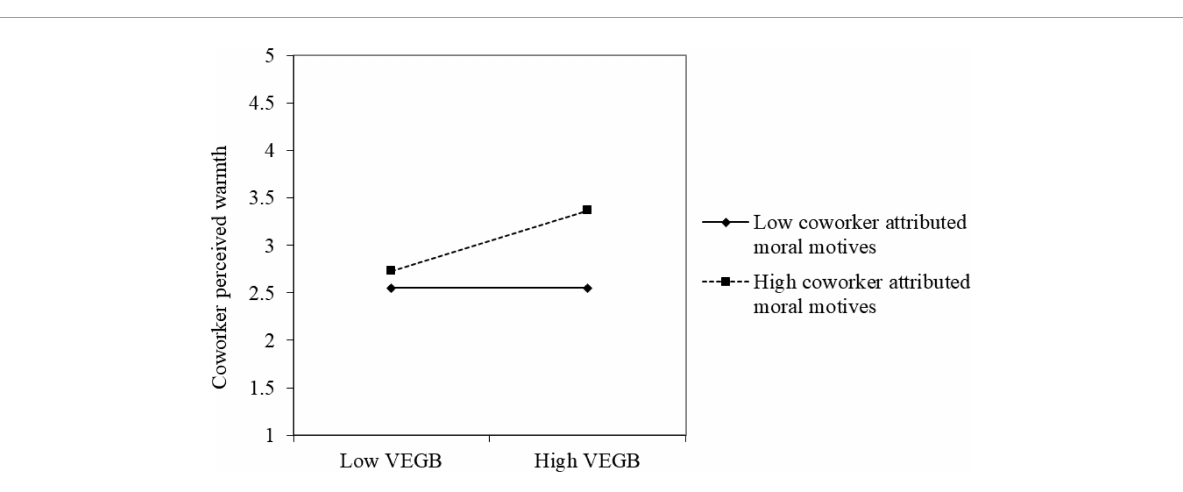
FIGURE3 The interactive effect of VEGB coworker-attributed moral motives on perceived